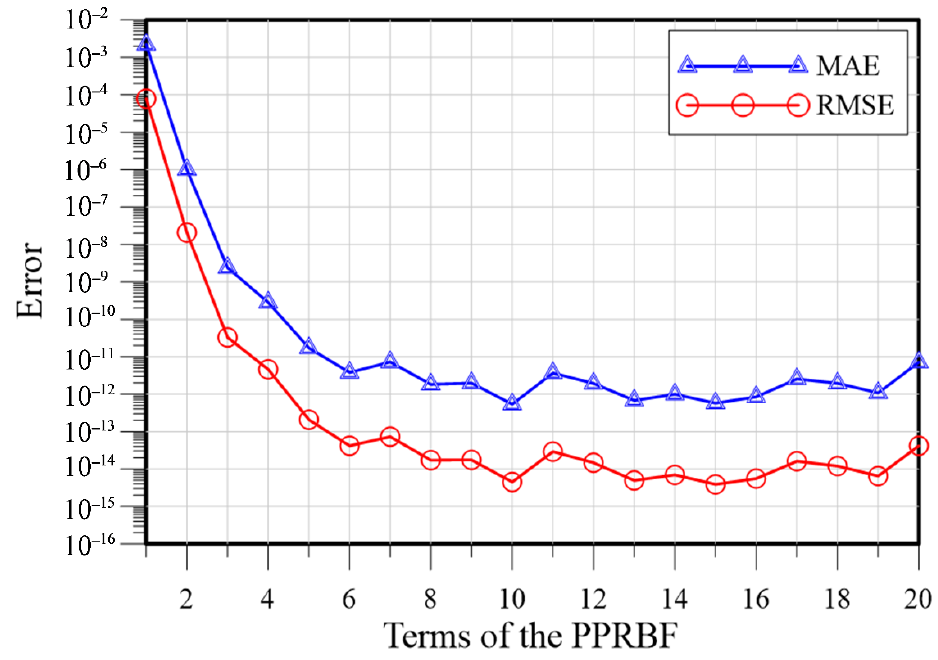
Figure 8. Error versus the terms the PPRBF.